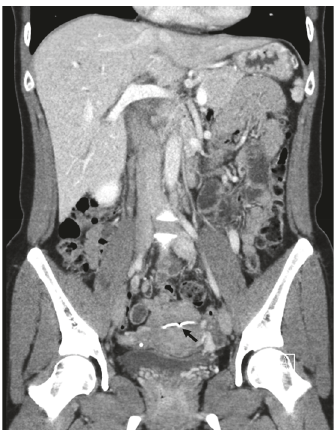
Figure 4: Case # 2, Mirena hormonal intrauterine device in uterus (arrow), CT of